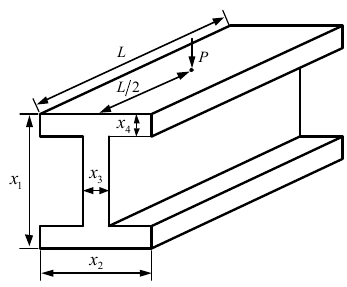
Figure 2. Schematic of I-beam design (IBD).